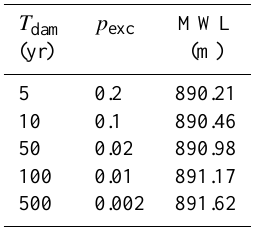
Table 7. Maximum water level reached for different return periods (MWL) associated to the probability of exceeding a water level for E =889m and L